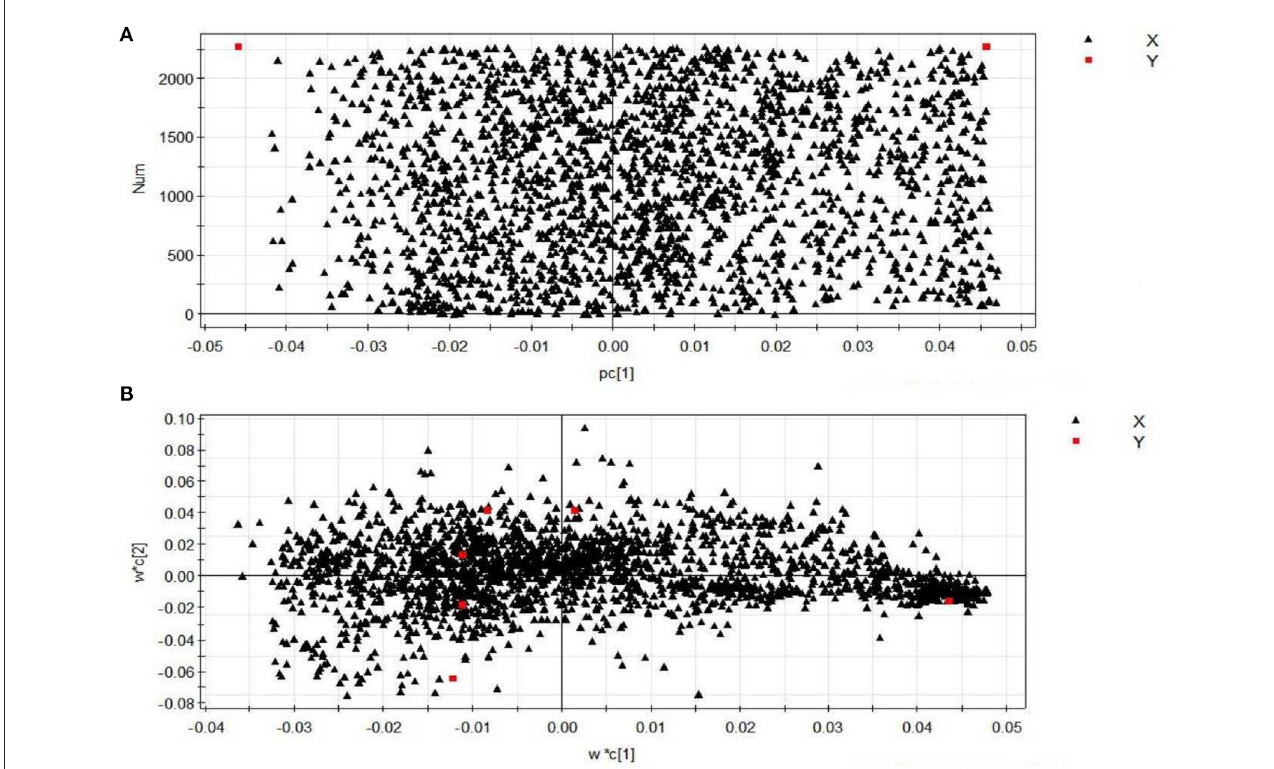
FIGURE7 Loading plots of serum samples from different groups of mice (positive): (A) normal control group (NC)–model group (MOD) mouse serum sample loading diagram; (B) different doses of PEP group–positive control group–high fat model group mouse serum sample loading diagram.